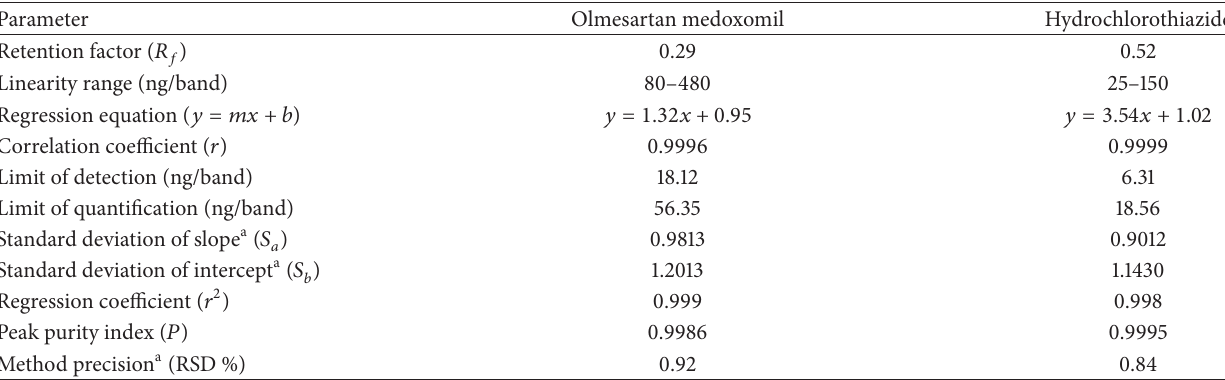
Figure 4: Peak purity spectra of (a) OLM and (b) HTZ. The wavelength selected for analysis was 258 nm. Table 1: Linearity parameters for calibration